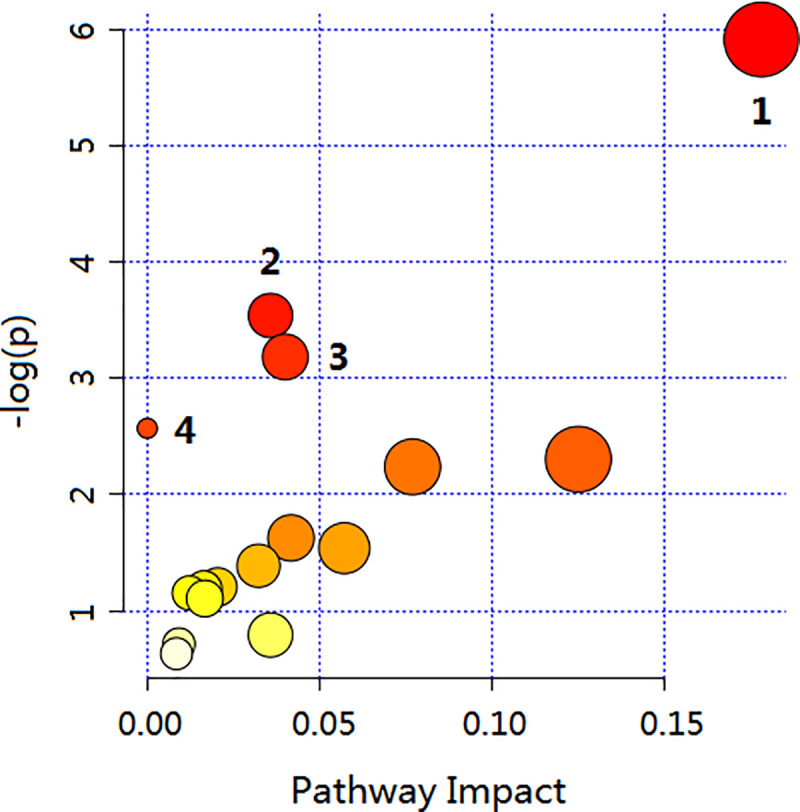
Bubble chart of pathway enrichment analysis.Each dot represents a metabolic pathway, and the label corresponds to the number of pathways in Table 3.